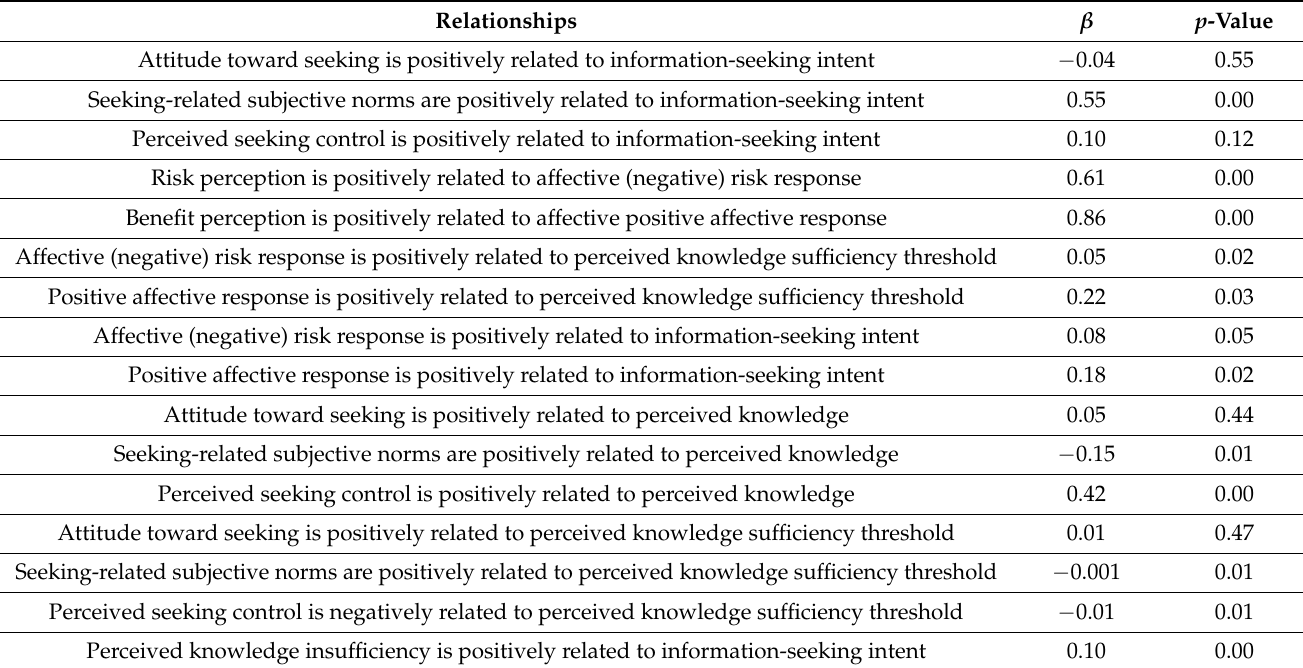
Table 4. Relationship Coefficients ( β ) and Corresponding p